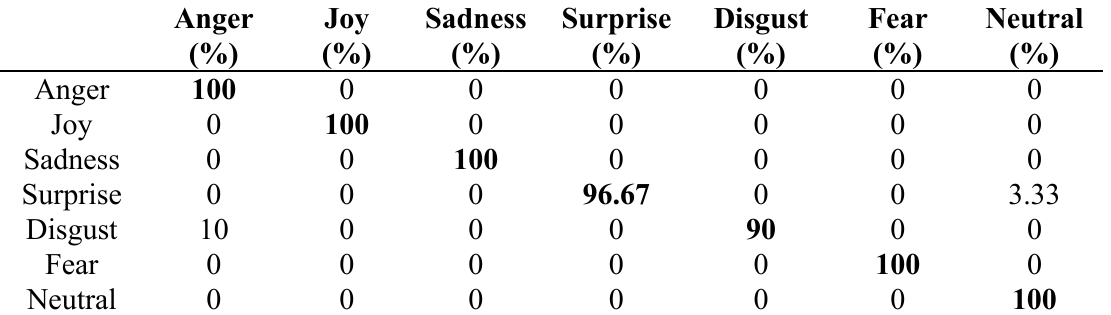
Table 5. Confusion matrix of recognition results of SRC with 50 reduced Gabor wavelets representation.